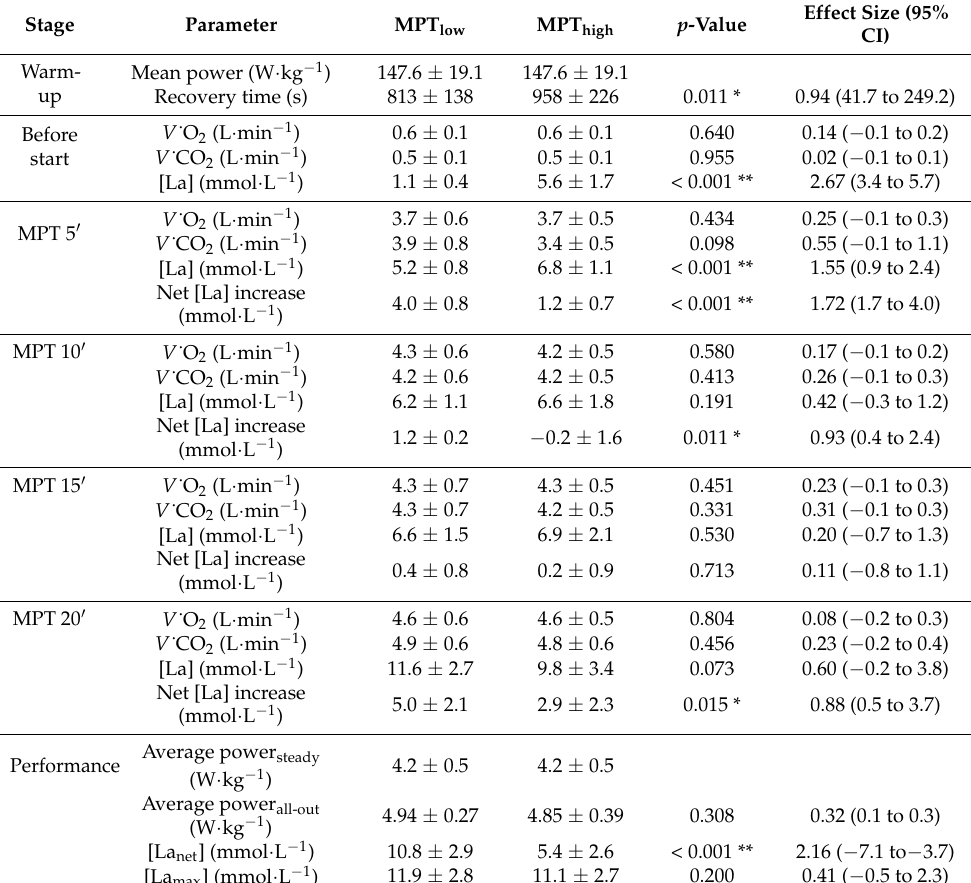
Table 2. Physiological changes throughout MPTs ( n =